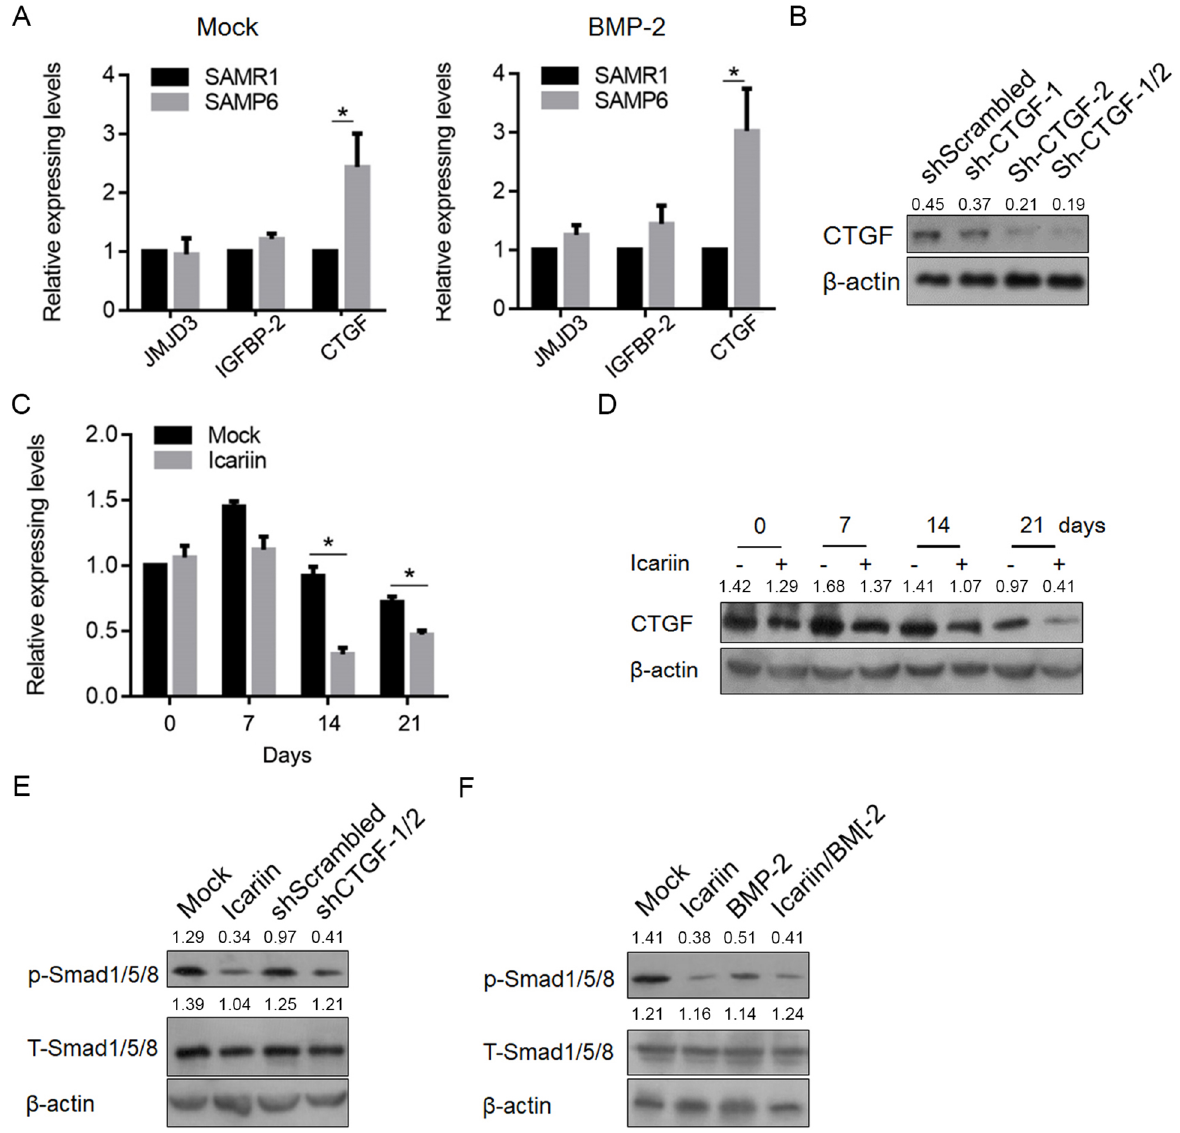
Fig 5. Icariin regulates SAMP6 osteoblasts via transcriptionally regulating CTGF . (A) RT-qPCR and semiquantitative Western blotting were performed to measure the JMJD3, IGFBP-2 and CTGF expression levels. (cid:3) P < 0.05 vs. SAMR1. (B) Knockdown of CTGF by si CTGF efficiently decreased the CTGF protein levels in SAMP6 osteoblasts. (C) Knockdown of CTGF decreased the proliferation of SAMP6 osteoblasts. (cid:3) P < 0.05 vs. mock group. (D) After 7-, 14-, and 21-day exposure to icariin, the expression level of CTGF was measured. (E) Icariin exposure activated the phosphorylation of Smad-1/5/8. (F) The effects of icariin exposure and CTGF knockdown on SAMP6 osteoblasts were dependent on Smad-1/5/8.